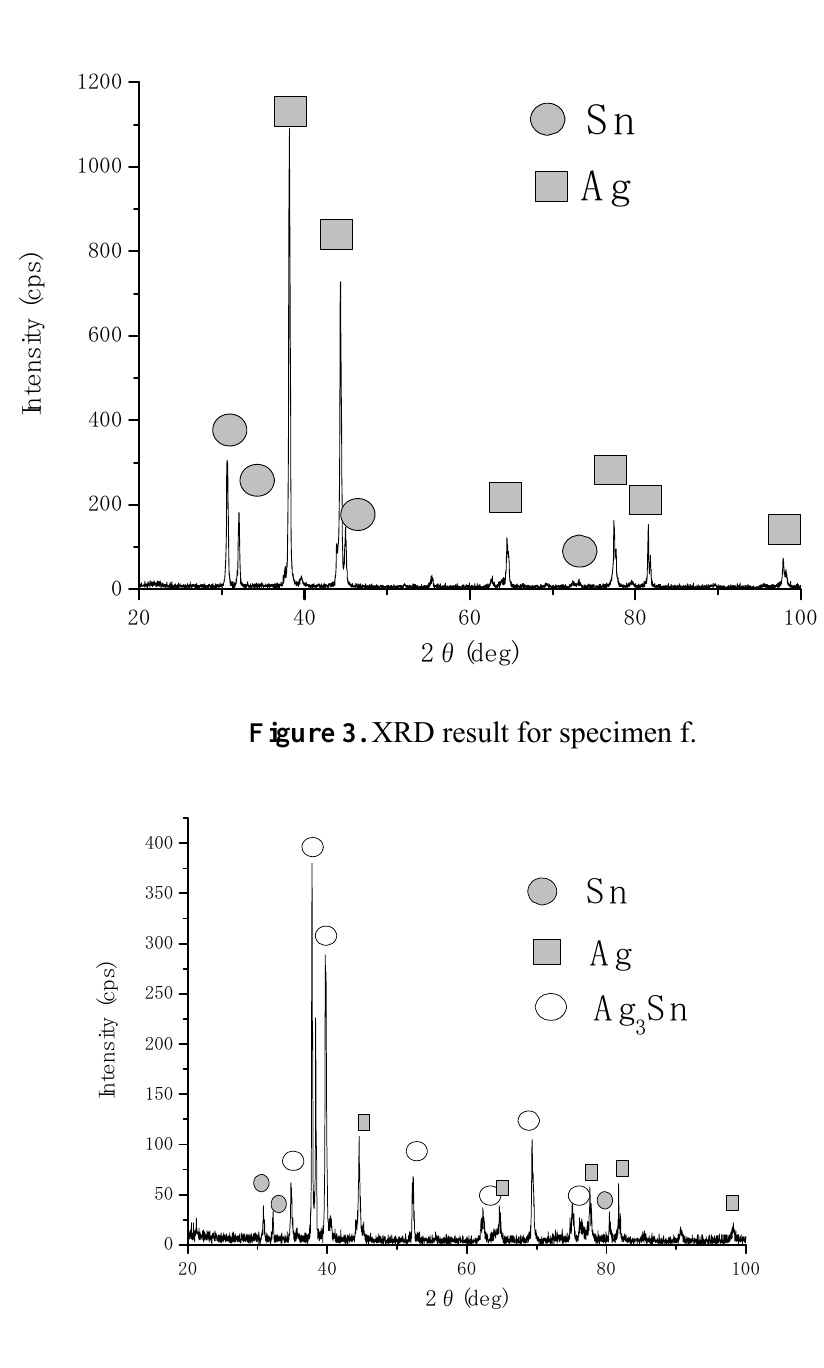
Figure 2. XRD result for specimen e.